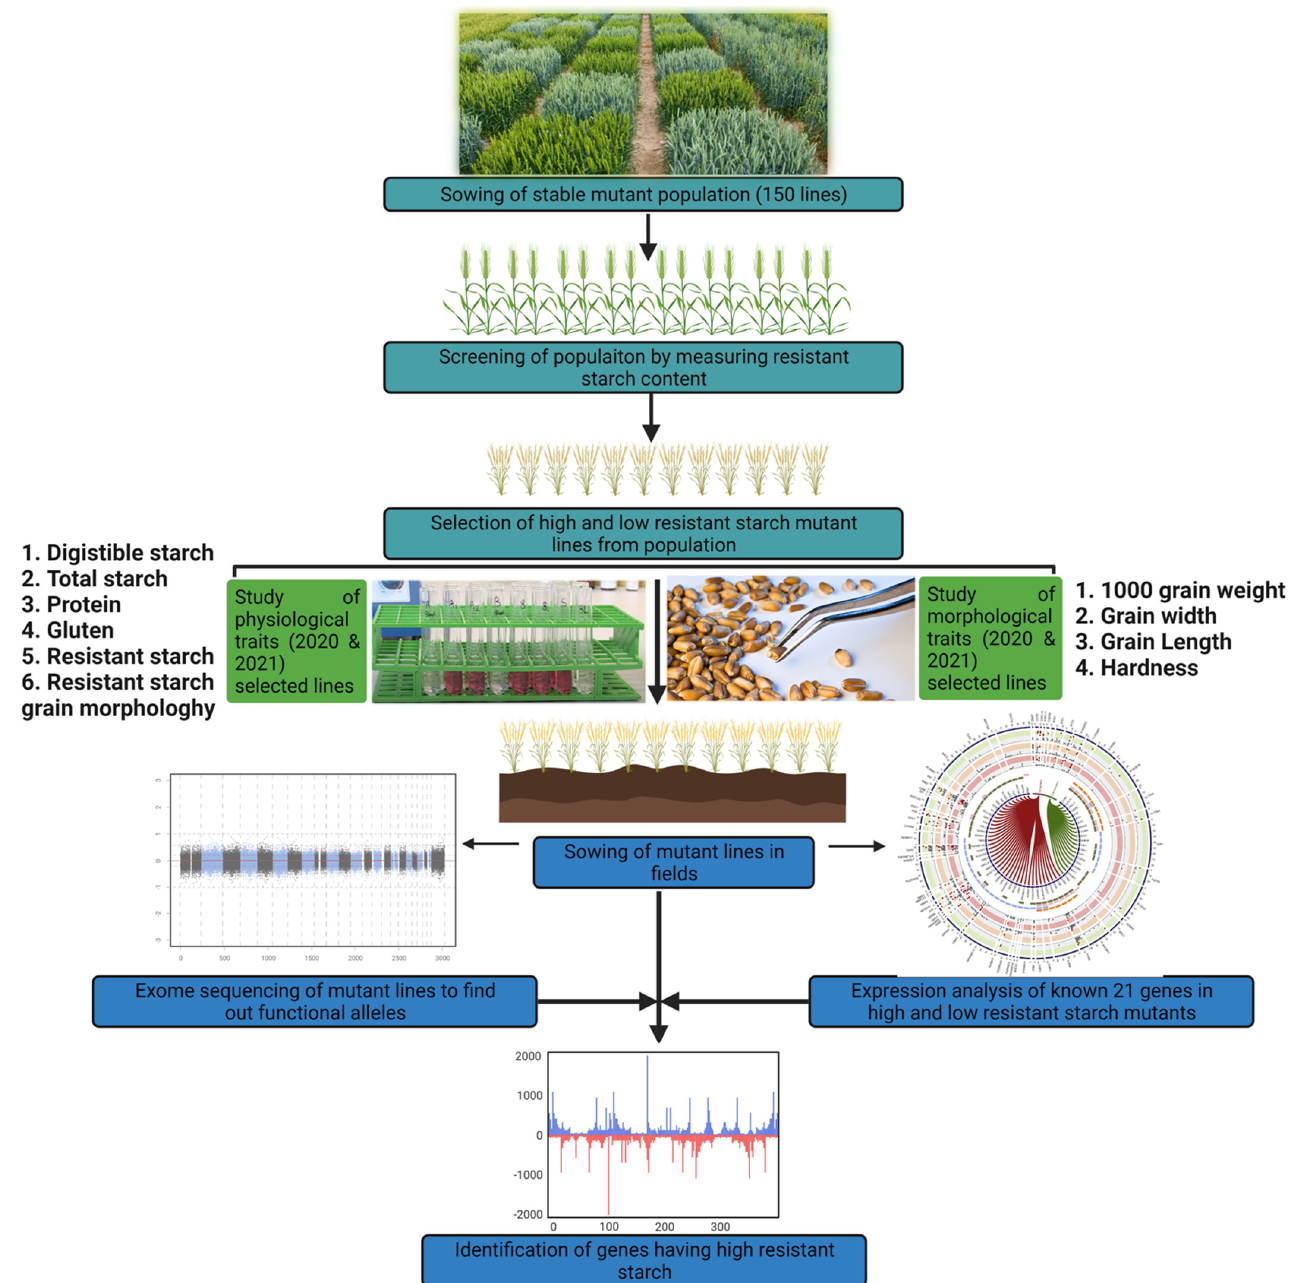
Figure 1. A schematic diagram of the overall